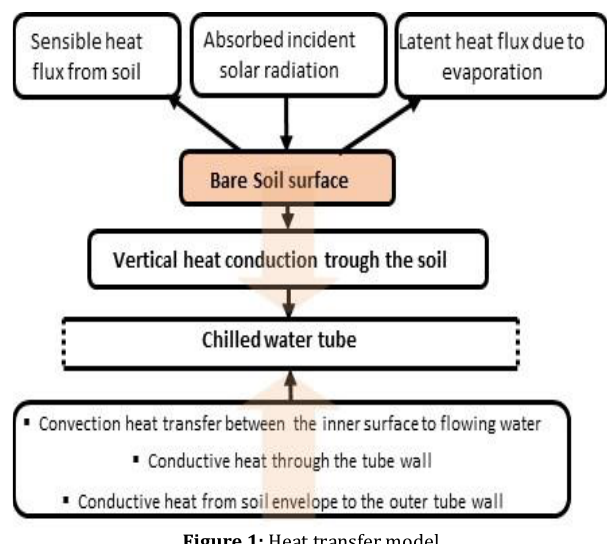
Figure 1: Heat transfer model